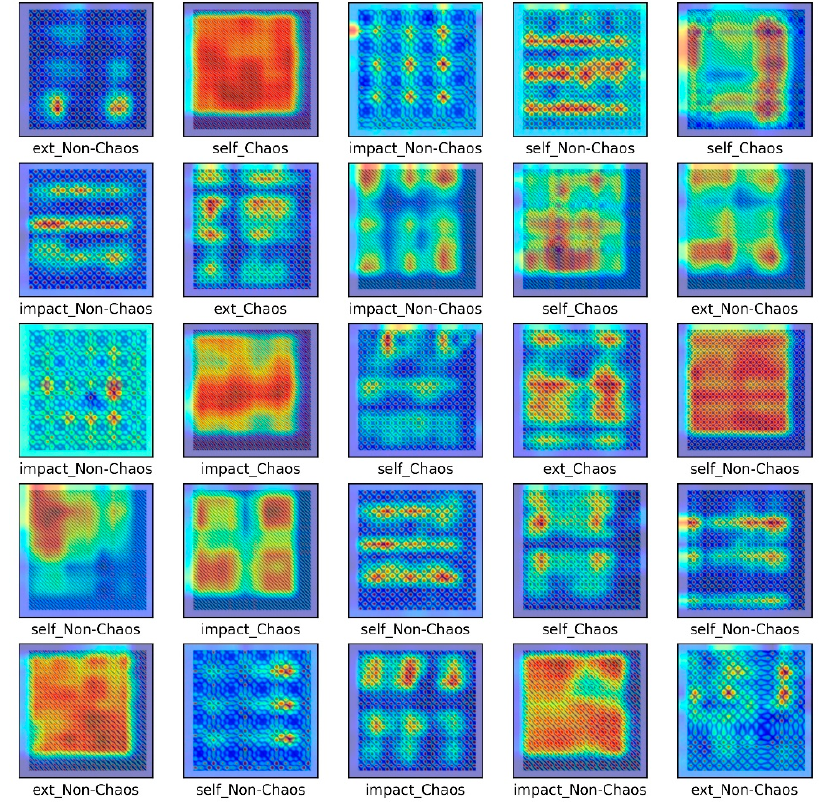
Figure 17. Class activation map for the S&R model.